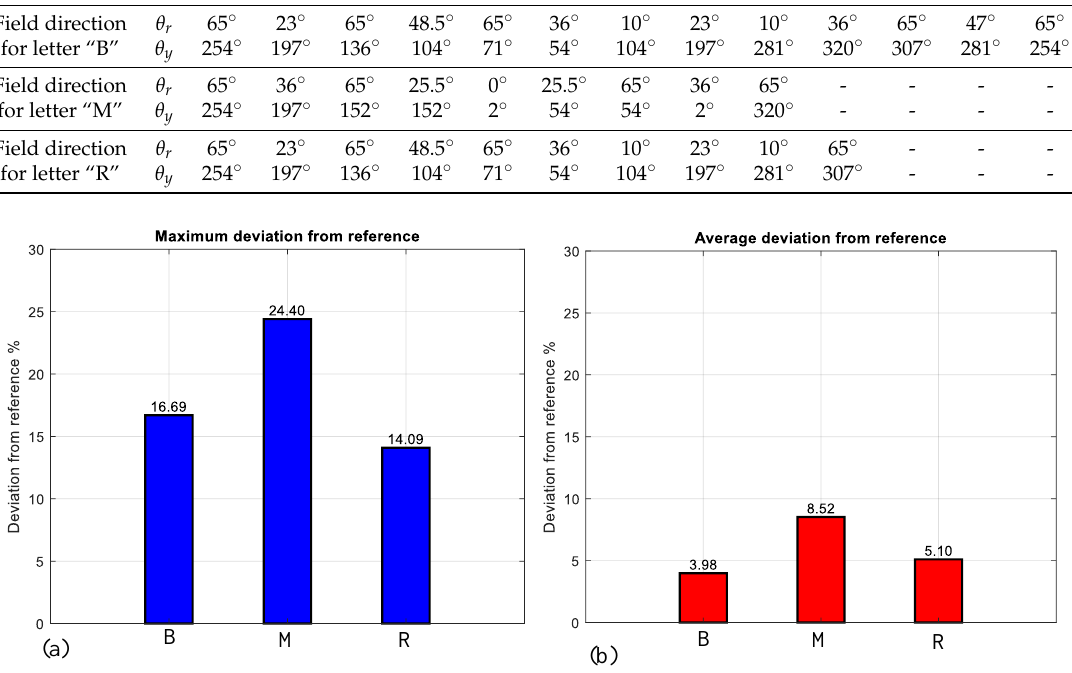
Figure 8. ( a ) Maximum and ( b ) average deviation between the desired path (using the initial letters of the BMR) and the experimental